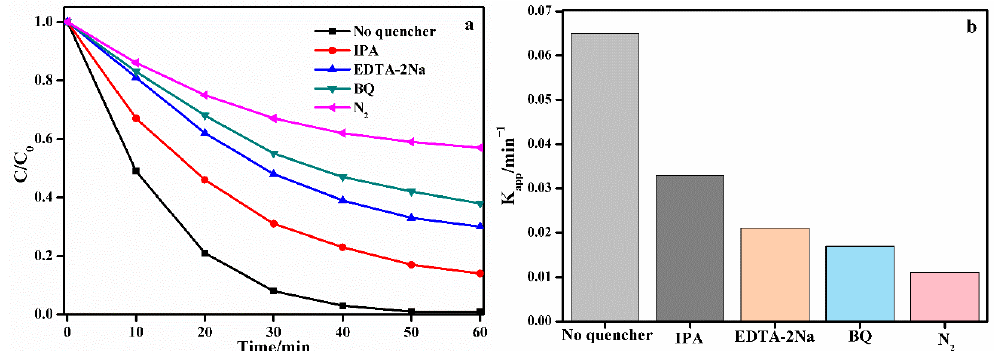
Figure 11. ( a ) Photocatalytic activities of AgI@TCNQ composites with different quenchers for methylene blue (MB) degradation. ( b ) Various rate-constant k apps with different quenchers.